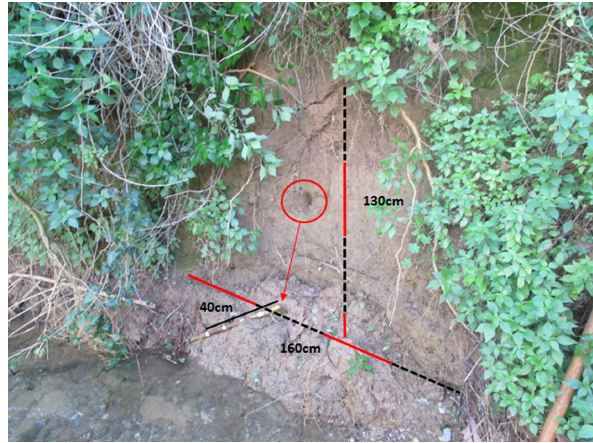
Figure 4. Photo highlighting the riverbank location (KI) with the most intense observed erosion accompanied by the appropriate scaled tools to provide a rough estimate of the eroded